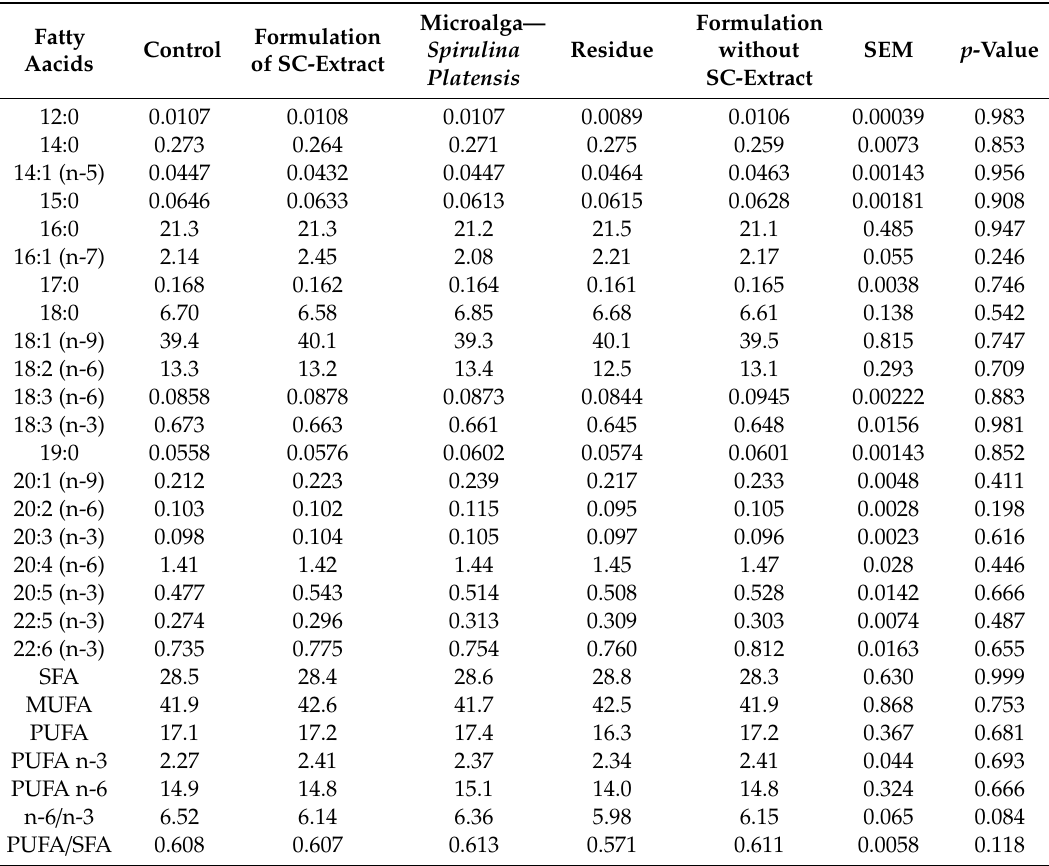
Table 5. The content of FAs in eggs (% weight of FAs in the sample) after 30 days of the